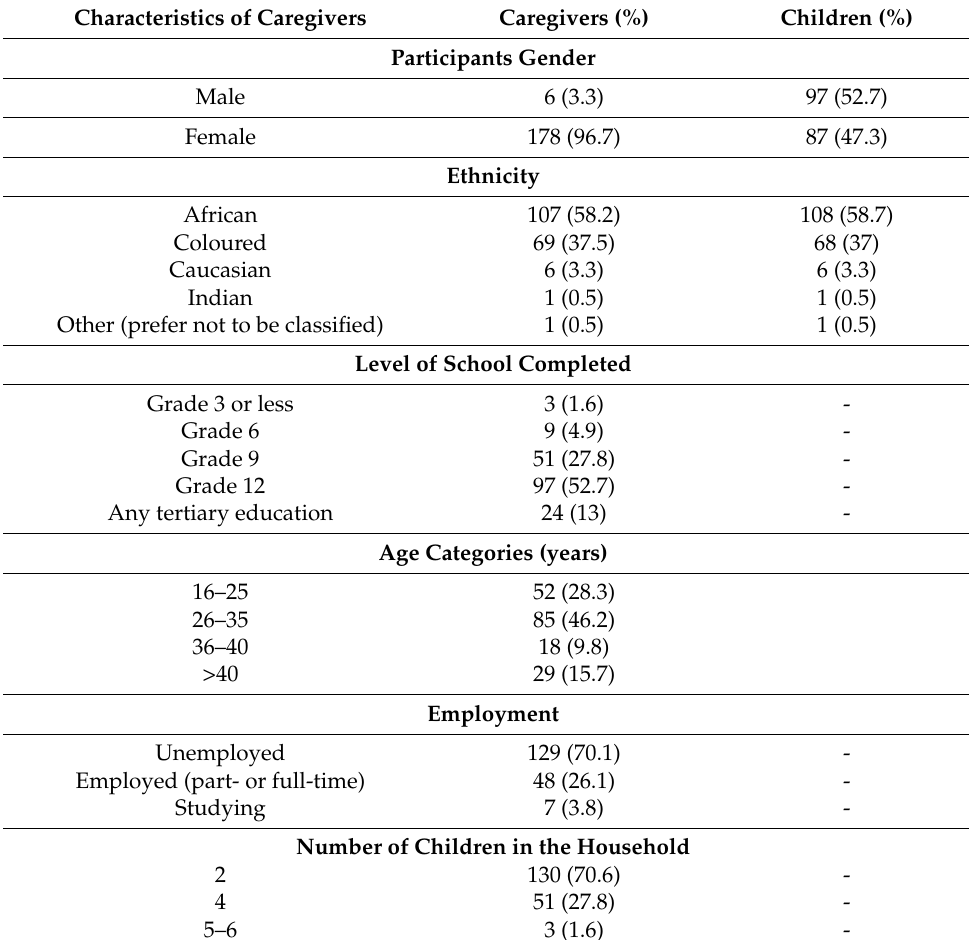
Table 2. Caregivers’